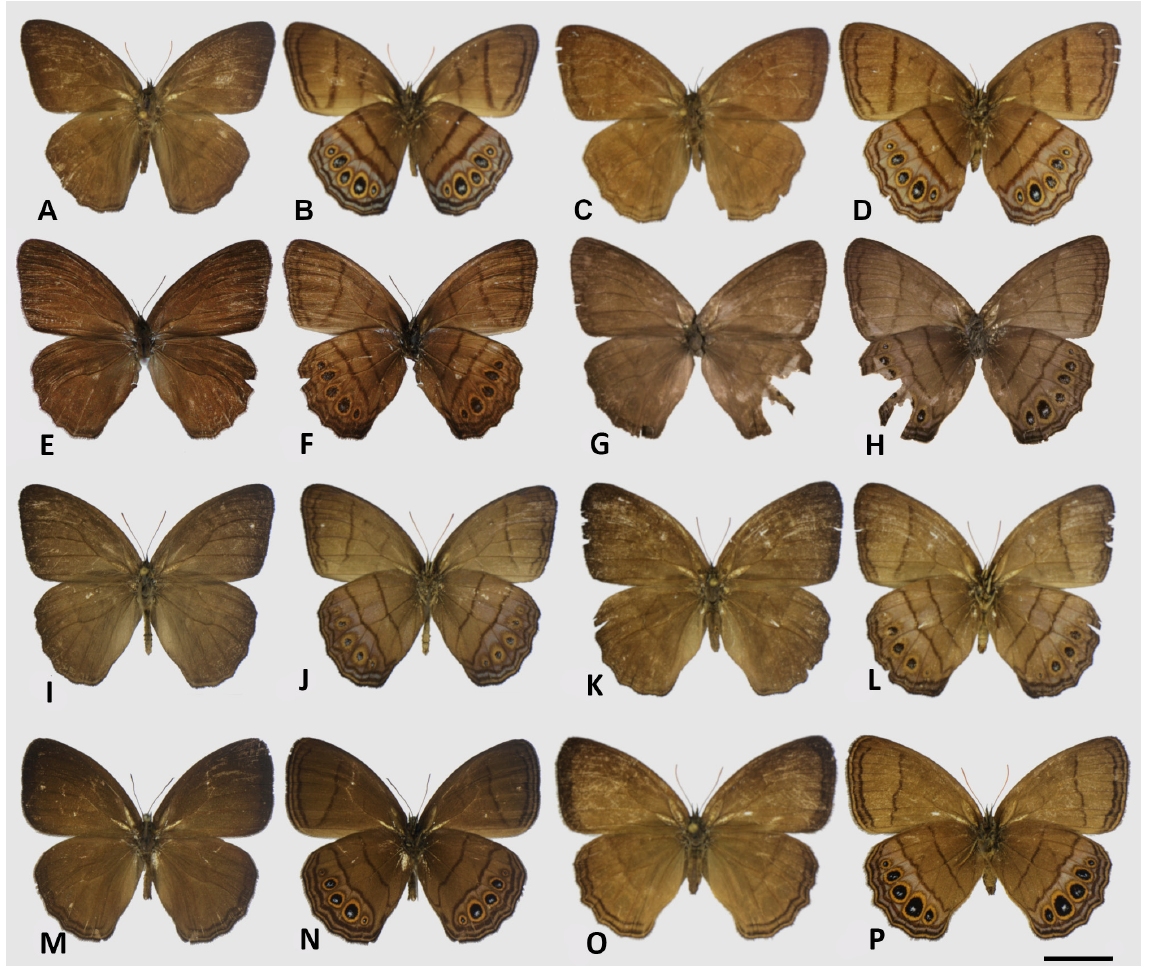
Fig. 3. Zischkaia “ saundersii clade”, wing plate. A–B . Z. saundersii (Butler, 1867), ♂ (DZ 37. 029), dorsal and ventral views. C–D . Z. saundersii , ♀ (DZ 36. 969), dorsal and ventral views. E–F . Z. josti Nakahara & Kleckner, sp. nov., holotype, ♀, dorsal and ventral views. G–H . Z. josti sp. nov., paratype, ♀ (USNM ENT 00233844), dorsal and ventral views. I–J . Z. mielkeorum Dolibaina, Dias & Zacca, sp.